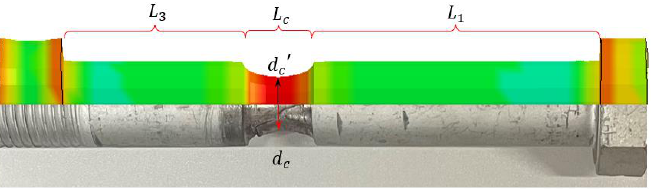
, ( b ) B (cid:48) , ( c ) C (cid:48) , ( d ) bolt fracture. 1 1 1